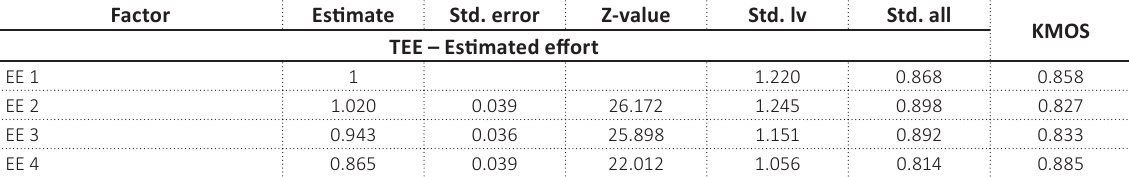
Source: Own processing.